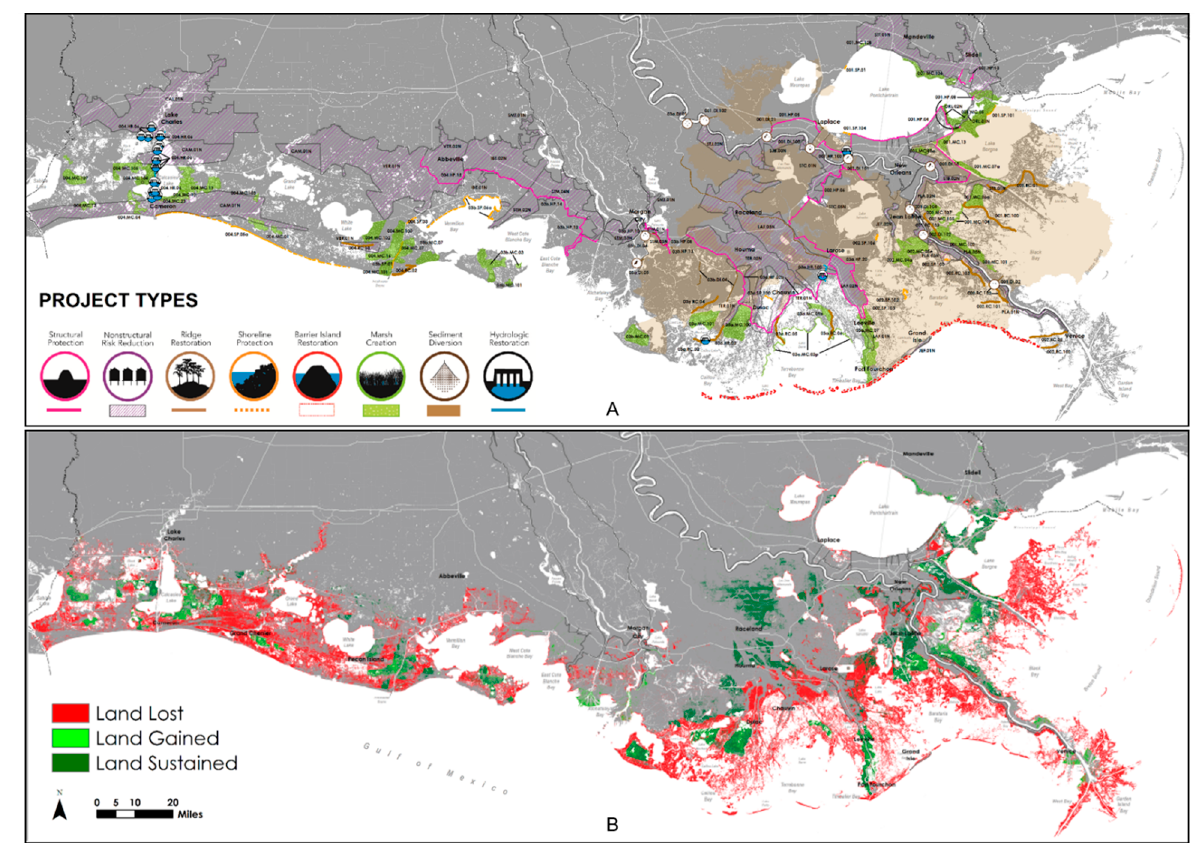
Figure 3. ( A ) The 2017 Coastal Master Plan recommends 124 projects, with a projected $150 billion in flood damage reductions for the medium environmental scenario at year 50 [22]. ( B ) Land lost, gained, and sustained with the 2017 Coastal Master Plan for the medium environmental scenario, with a projected 2077 square kilometers of land gained or sustained at year 50.